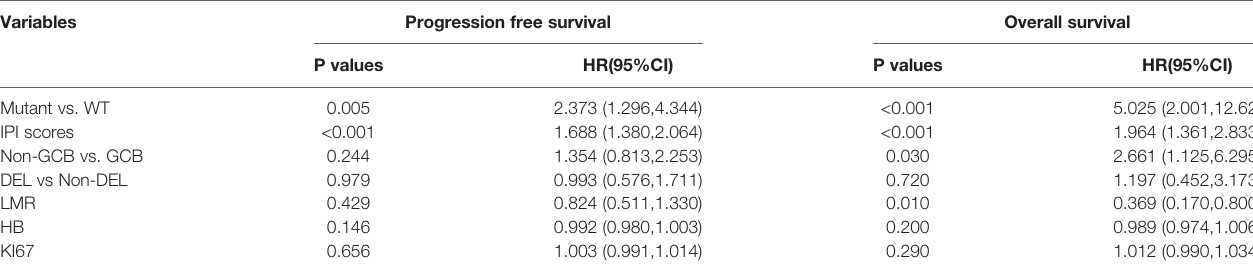
TABLE 1 | Multivariable analyses of PFS and OS in DLBCL patients. Variables Progression free